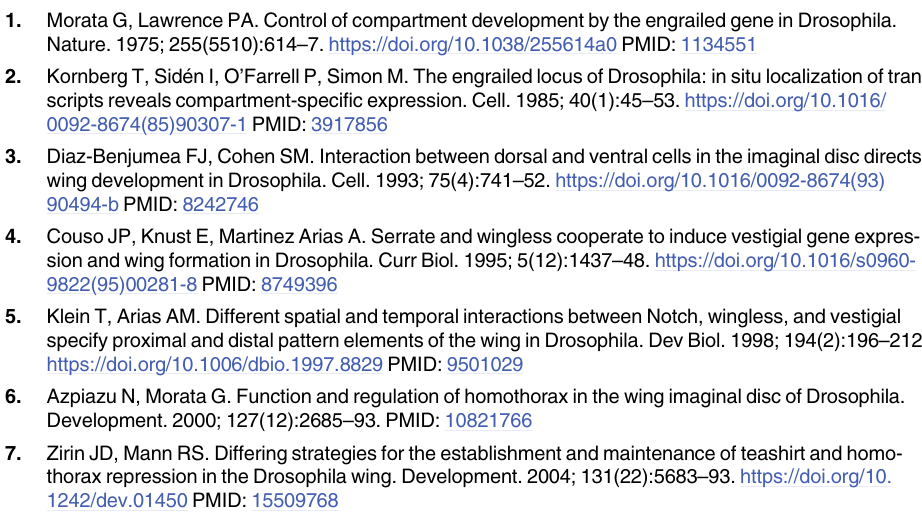
S1 Table. Genotypes and experimental conditions. Detailed genotypes and experimental conditions of data represented in the